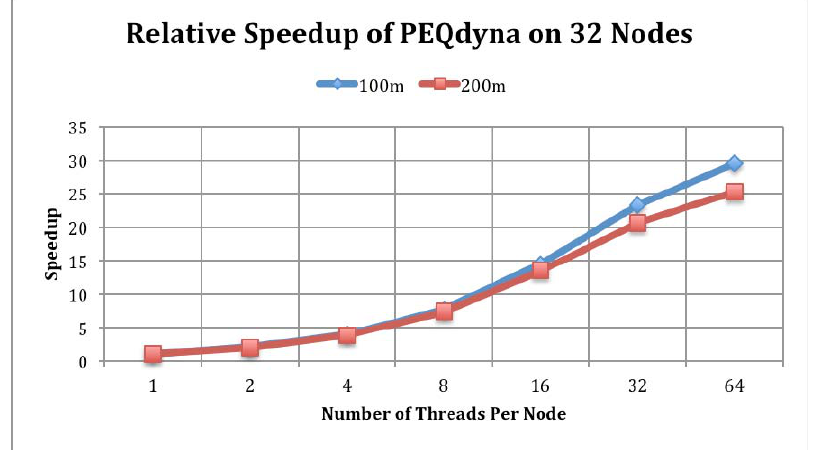
Figure 8. Performance comparison of PEQdyna on 32 Nodes with different number of threads per node